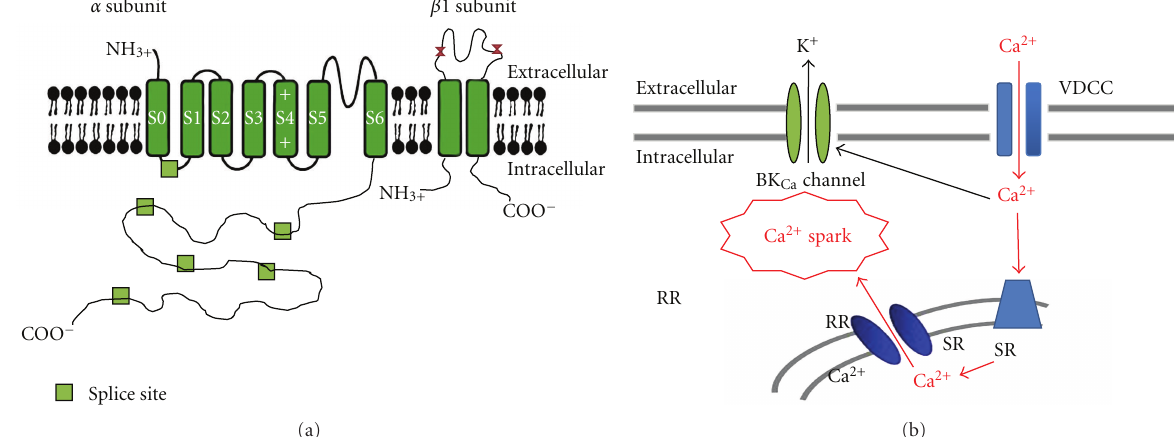
Figure 2: Structure and physiology of BK Ca channels. (a) BK Ca channels are composed of two di ff erent subunits: the pore-forming α subunit and the auxiliary β subunits. A functional channel is made up by the association of four α and four β 1 subunits. Although a single gene codes for α , splicing leads to variants that are di ff erent in biophysical properties and/or intracellular localization. (b) In smooth muscles, membrane depolarization and/or intracellular Ca 2+ cause the influx of Ca 2+ through voltage-dependent Ca 2+ channels (VDCCs). This in turn causes a rise in intracellular Ca 2+ levels and smooth muscle contraction. Increases in Ca 2+ levels facilitate Ca 2+ binding to ryanodine receptors (RRs) in the sarcoplasmic reticulum (SR), which produces a localized Ca 2+ release (Ca 2+ spark) that activates the BK Ca channels. Activation of BK Ca channels causes e ffl ux of K + , hyperpolarization of the cell membrane, closure of VDCC, prevention of Ca 2+ entry, and eventually smooth muscle relaxation. Adapted from Garcia et al.